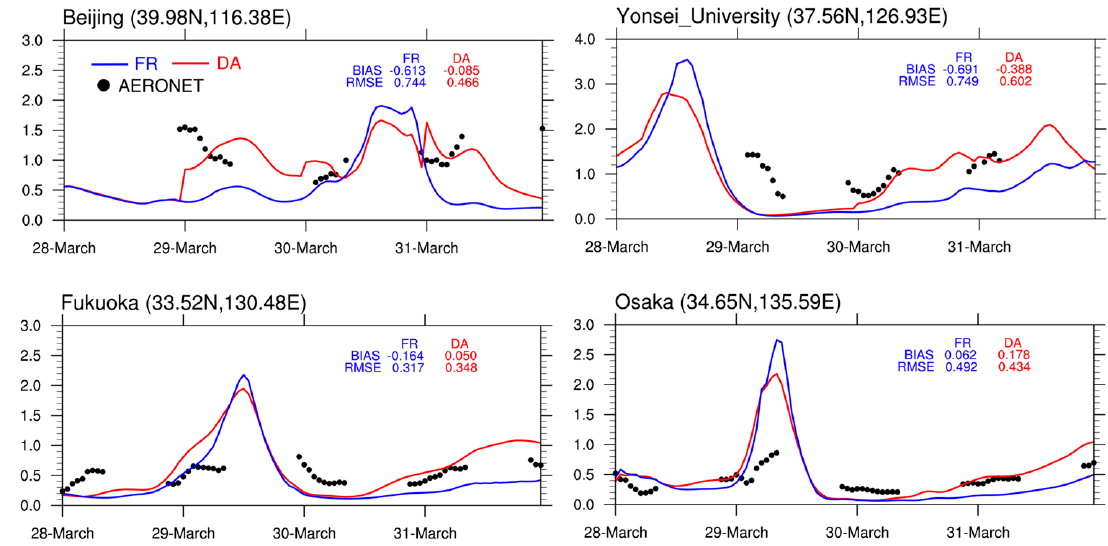
Figure 6. Time series of simulated AOTs at 440 nm for two experiments (FR in blue and DA in red) and AERONET-observed AOTs (dots in black) at 440 nm over four sites. Biases and root mean square errors (RMSEs) between AOTs simulated by the two experiments and AERONET-observed AOTs are shown.